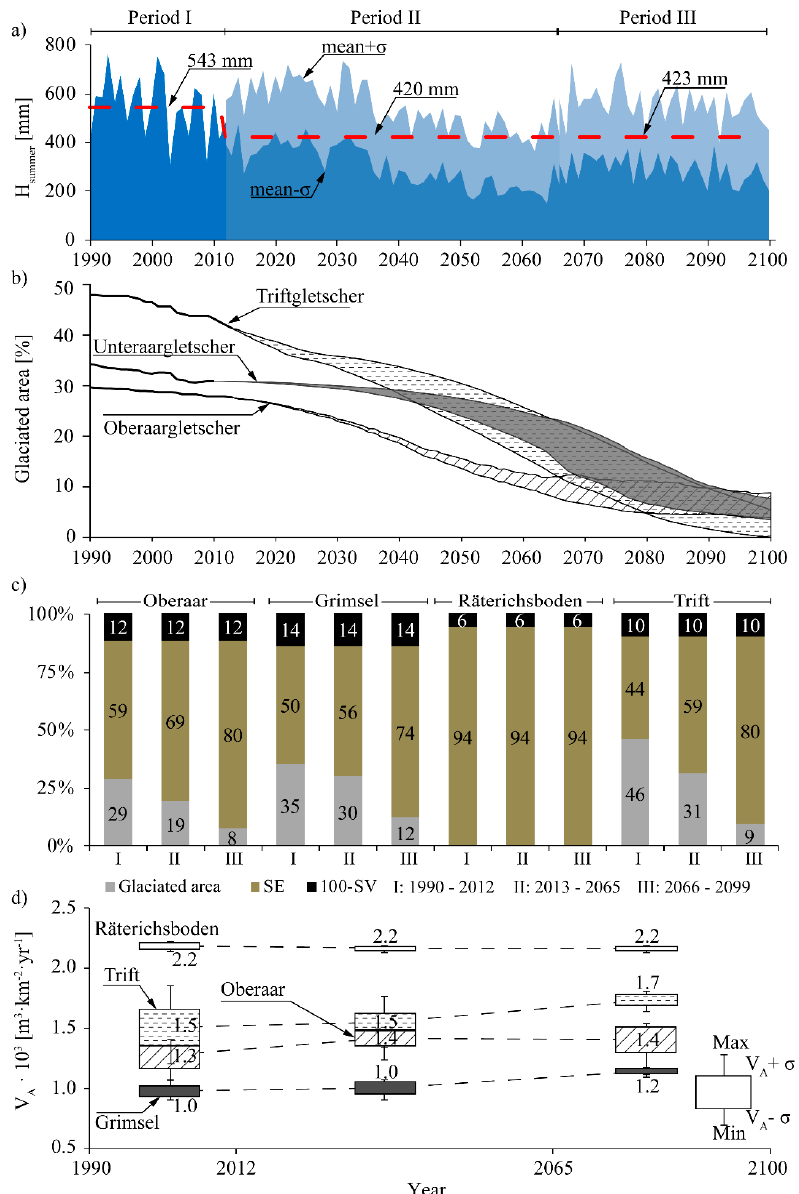
Figure 3. ( a ) Annual values of H summer from 1990 to 2099. From 1990 to 2012, the values correspond to those measured at the Grimsel-Hospiz gauging station. From 2013 to 2099, the figure shows the range of values (mean ± σ ) estimated according to the A1B-climate change scenario. The dashed line corresponds to the mean value of H summer for each period. ( b ) Evolution of the glaciated area for the three glaciers analyzed. From 1990 to 2012, the values were derived from field measurements. From 2013 to 2099, the figure shows the range of values (mean ± σ ) estimated according to A1B climate change scenarios. ( c ) Percentage of the glaciated area, erodible soil ( SE ), and vegetated surface (100- SV ), averaged for the three periods analyzed (I, II, and III), for each catchment. ( d ) Annual sediment yield per unit area of each catchment. The values correspond to V A averaged for each period.